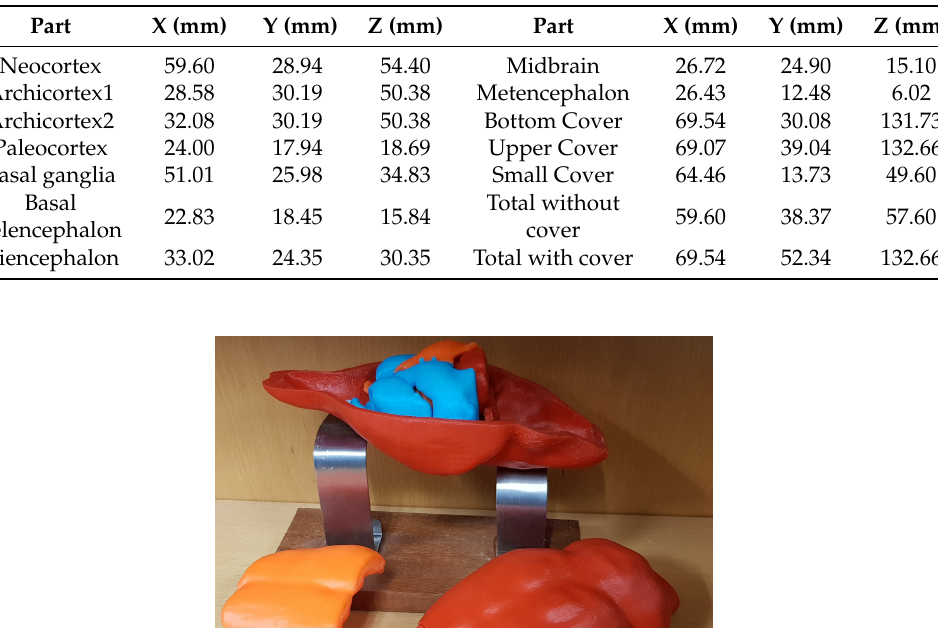
Table 2. Measurements on X, Y, and Z axes of each part, total assembly without container and total assembly with container.